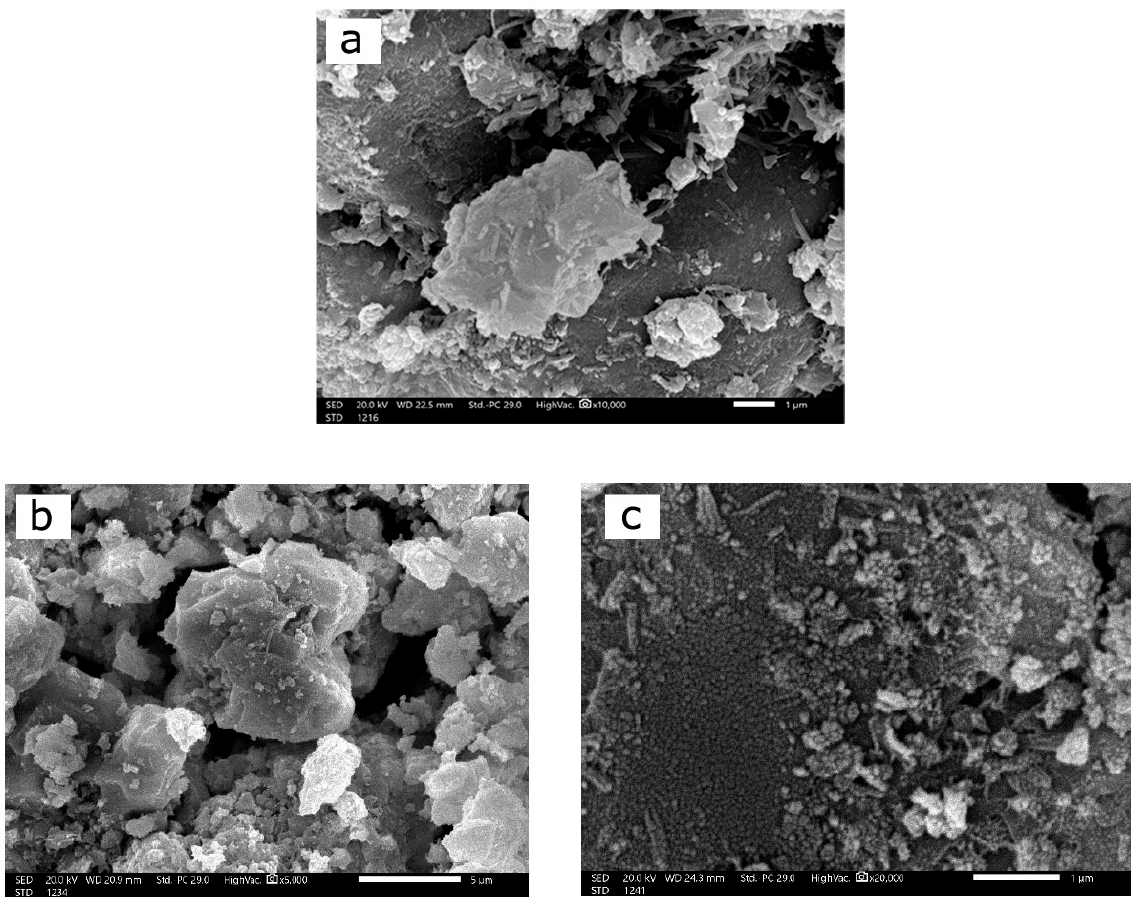
Figure 6. SEM images of ( a ) CM-Ctrl, ( b ) CM-MIS, and ( c ) CM-NIS mortar